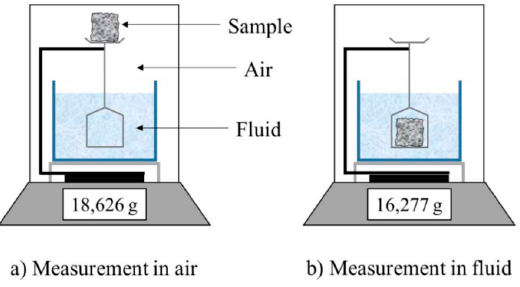
Figure 1. Scheme of Archimedes’ method for density measurement (adapted with permission, Elsevier,